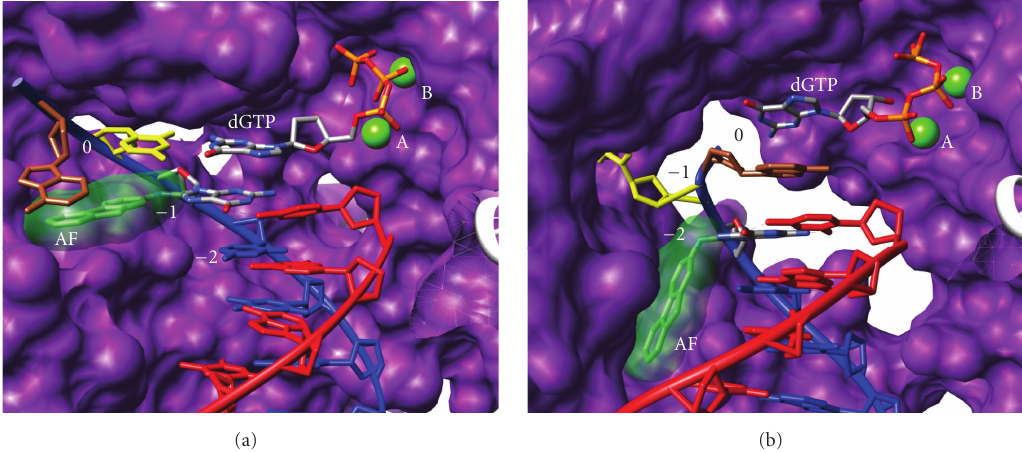
Figure 7: Two structures of Dpo4 ternary complexes in the presence of a dG-C8-AF adducted template, one forming a correctly aligned primer-template and a second forming a looped out structure of the template (PDB# 3KHH) [27]. (a) Correctly aligned primer template with the dGTP and corresponding template dC correctly at the 0 position. The adducted dG retains base paring with its corresponding dC while the AF is positioned towards the major groove and stacks in a pocket of the little fingers domain. The +1 templating base stacks on top of the AF adduct and is in alignment with the 0 position. (b) The misaligned structure contains the templating base in a looped out structure. The looped out base slides into a pocket, rotated away from the active site. As a consequence the +1 templating base rotates and stacks on top of the adducted dG base, and the DNA is shifted downwards as the +1 base now occupies the − 1 position within the polymerase. The AF adduct is rotated downwards and placed into a hydrophobic pocket within the little fingers domain. The dGTP does not contain any Watson-Crick binding partner as it occupies the 0 position and stacks onto of the template base